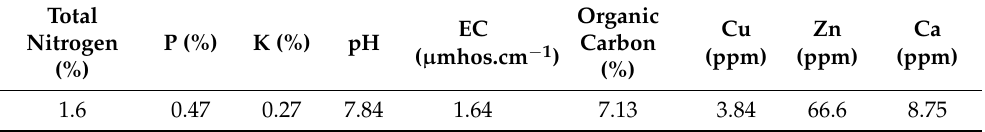
Table 5. Chemical properties of the vermicompost